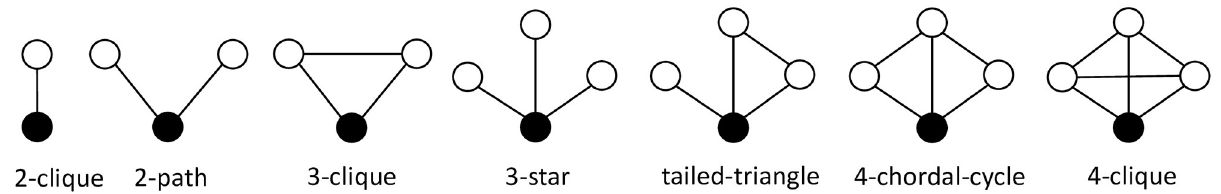
Fig 2. Egocentric graphlets of 2 to 4 nodes. There are in total seven egocentric graphlets. The black node in a given graphlet is the ego node, other nodes are alter